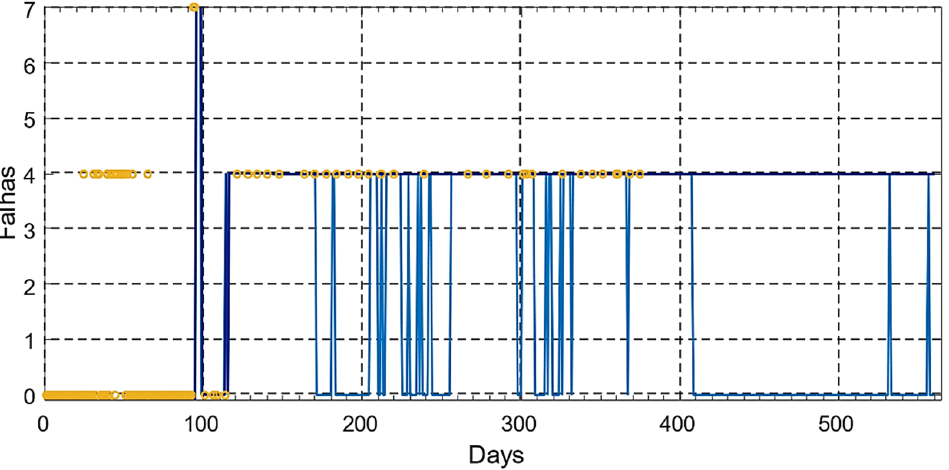
Figure 57. Evolution of failures according to the IEC method for offline (yellow), online without (dark blue), and with (blue) change rate conditions. Table 25. Codification of types of failures.